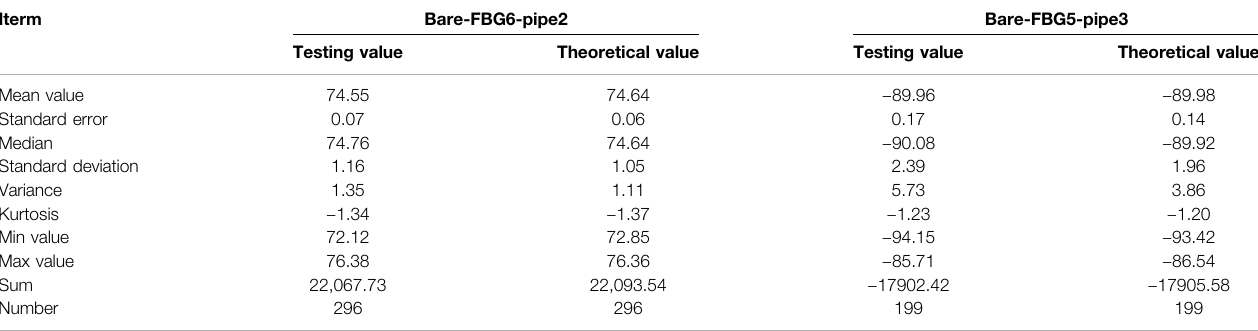
TABLE 1 | Statistical analysis on the measured